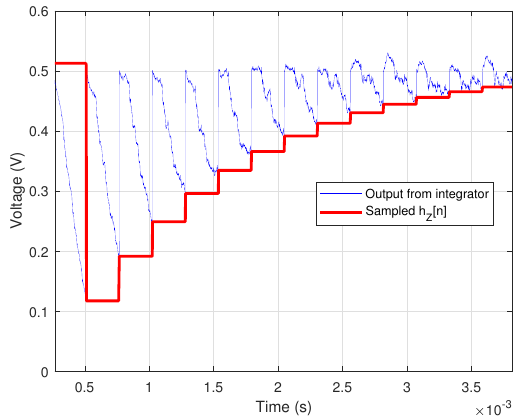
Figure 14. Detail of the cross-correlation operation. In Figure 15, the theoretical h z curve (green) is compared with the simulated results obtained from the MATLAB (red points) and SPECTRE (blue points) implementations, showing good agreement between